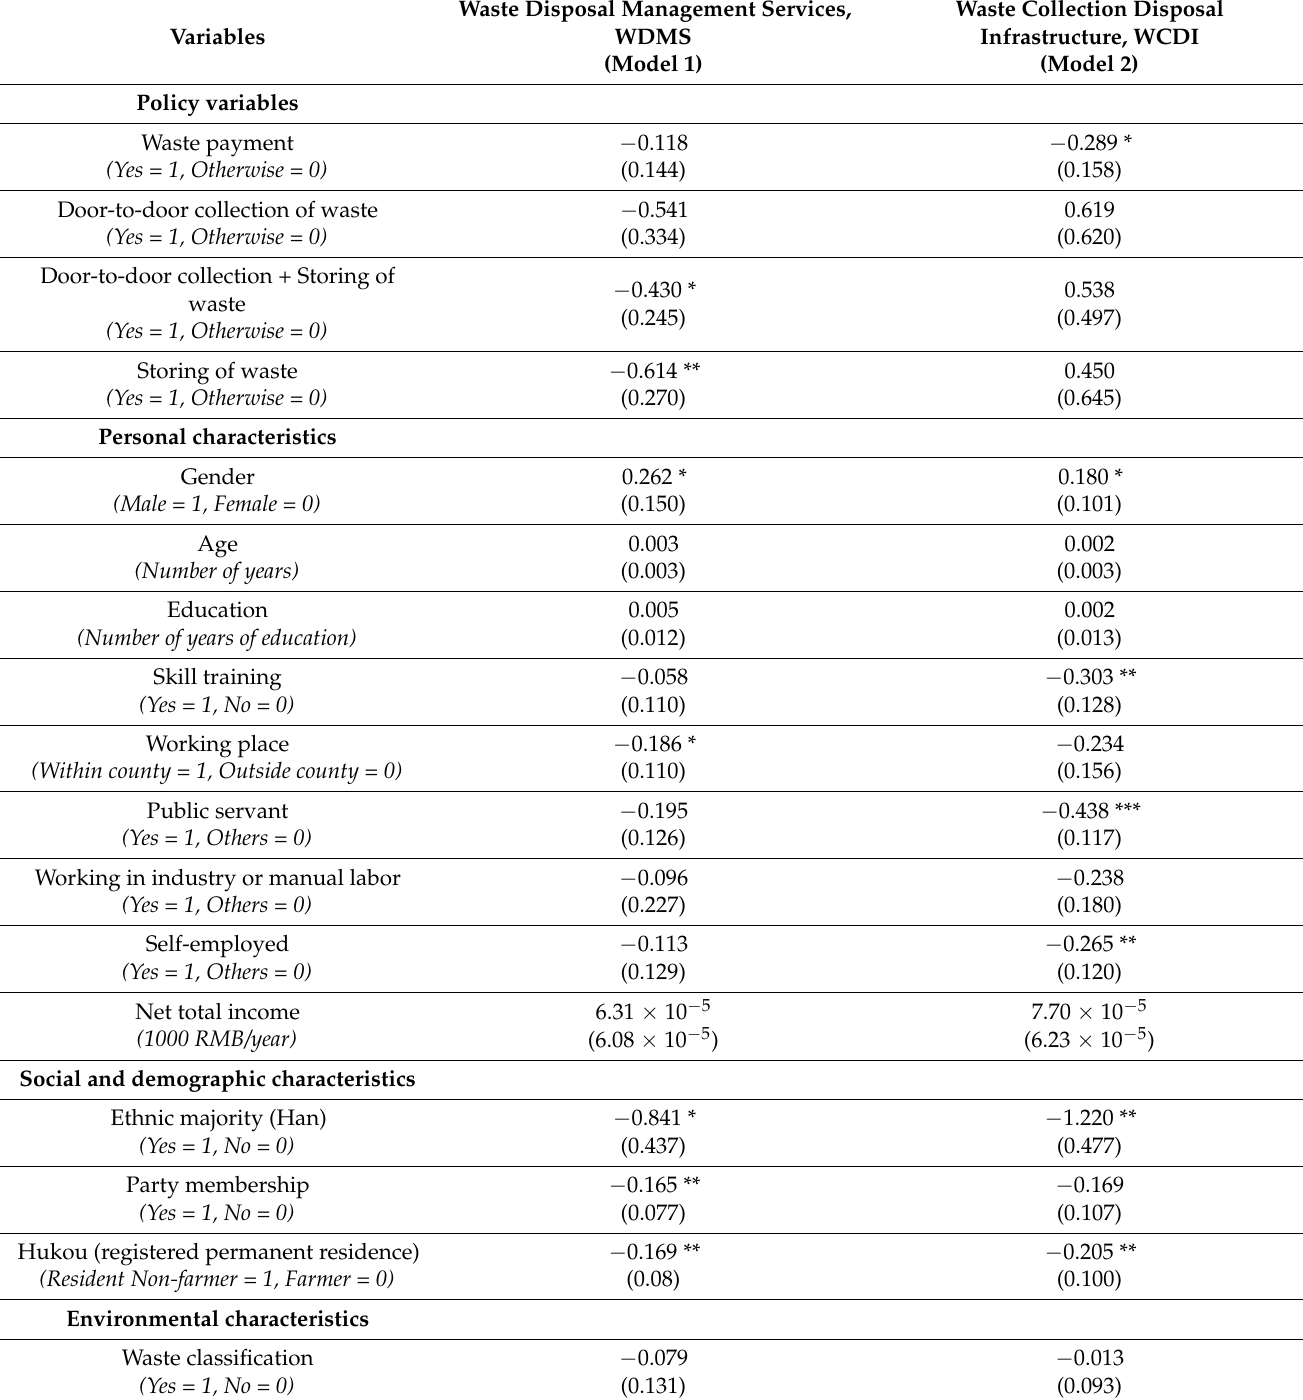
Table 1. Results of ordered probit models of satisfaction with RSW management